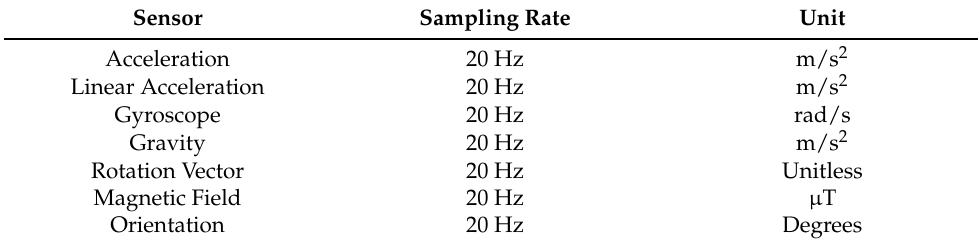
Table 1. List of sensors including sensor type, sampling rate, and